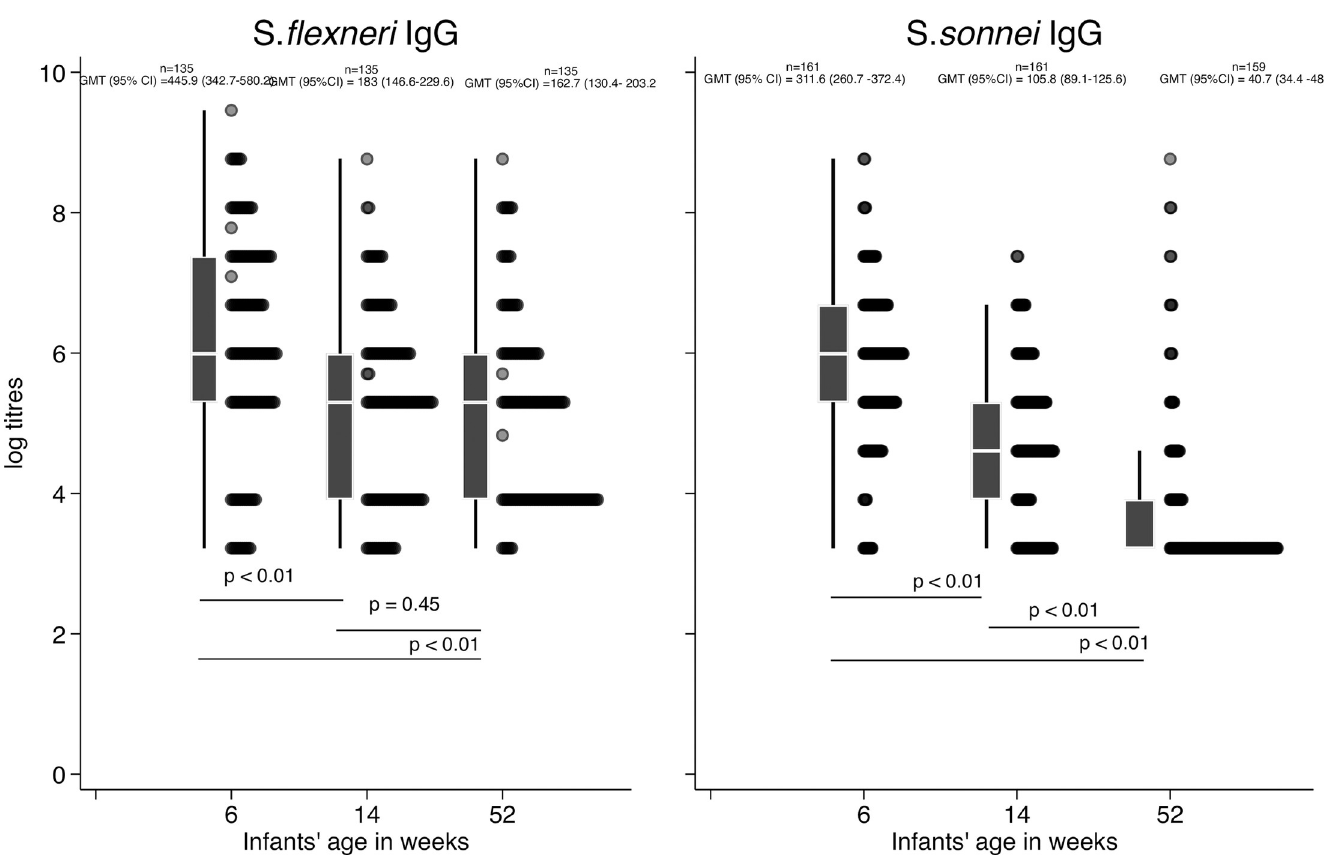
Fig 2. Kinetics of infant Shigella LPS specific IgG antibody titres form 6 to 52 weeks for S . flexneri 2a Panel A. Similarly, kinetics of S . sonnei Panel B. In both panels, transplacentally transferred maternal antibodies to S . flexneri 2a Panel A and S . sonnei Panel B were highest at 6 weeks and decreased by 52 weeks. The decrease is statistically significant between 6 and 14 and not between 14 and 52 weeks for antibodies to S . flexneri 2a LPS. A similar trend was observed for S. sonnei LPS IgG antibodies with the decrease when compared to 6 weeks titres statistically significant at all other time points.